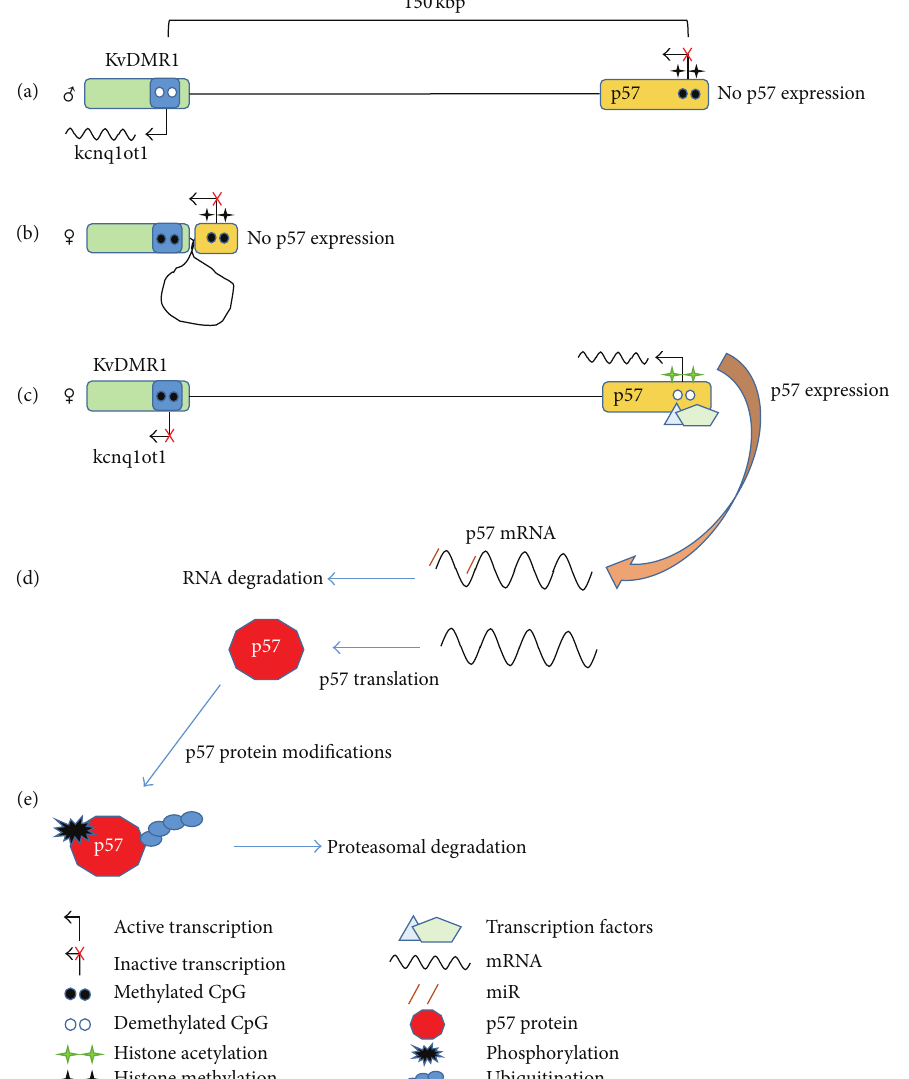
Figure 1: Different mechanisms of transcriptional and posttranscriptional p57 regulation. (a) Imprinting control on the paternal allele; (b) long-range intrachromosomal interactions between p57 promoter and KvDMR1 can repress the transcriptional expression; (c) promoter demethylation, active histone marks, and transcriptional factors binding regulate p57 expression; (d) p57 mRNA stability is regulated by miR; (e) p57 protein stability is regulated by phosphorylation and